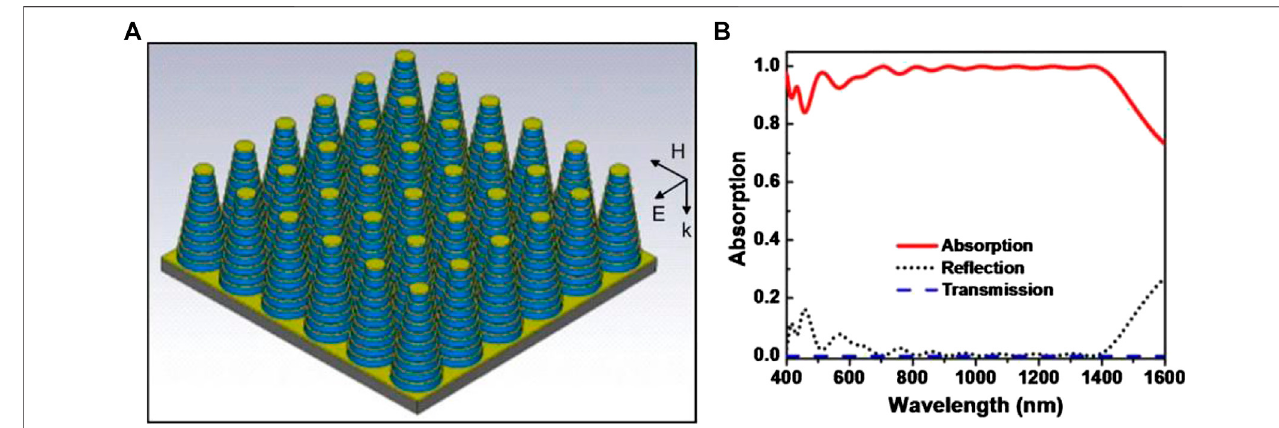
Frontiers in Physics |